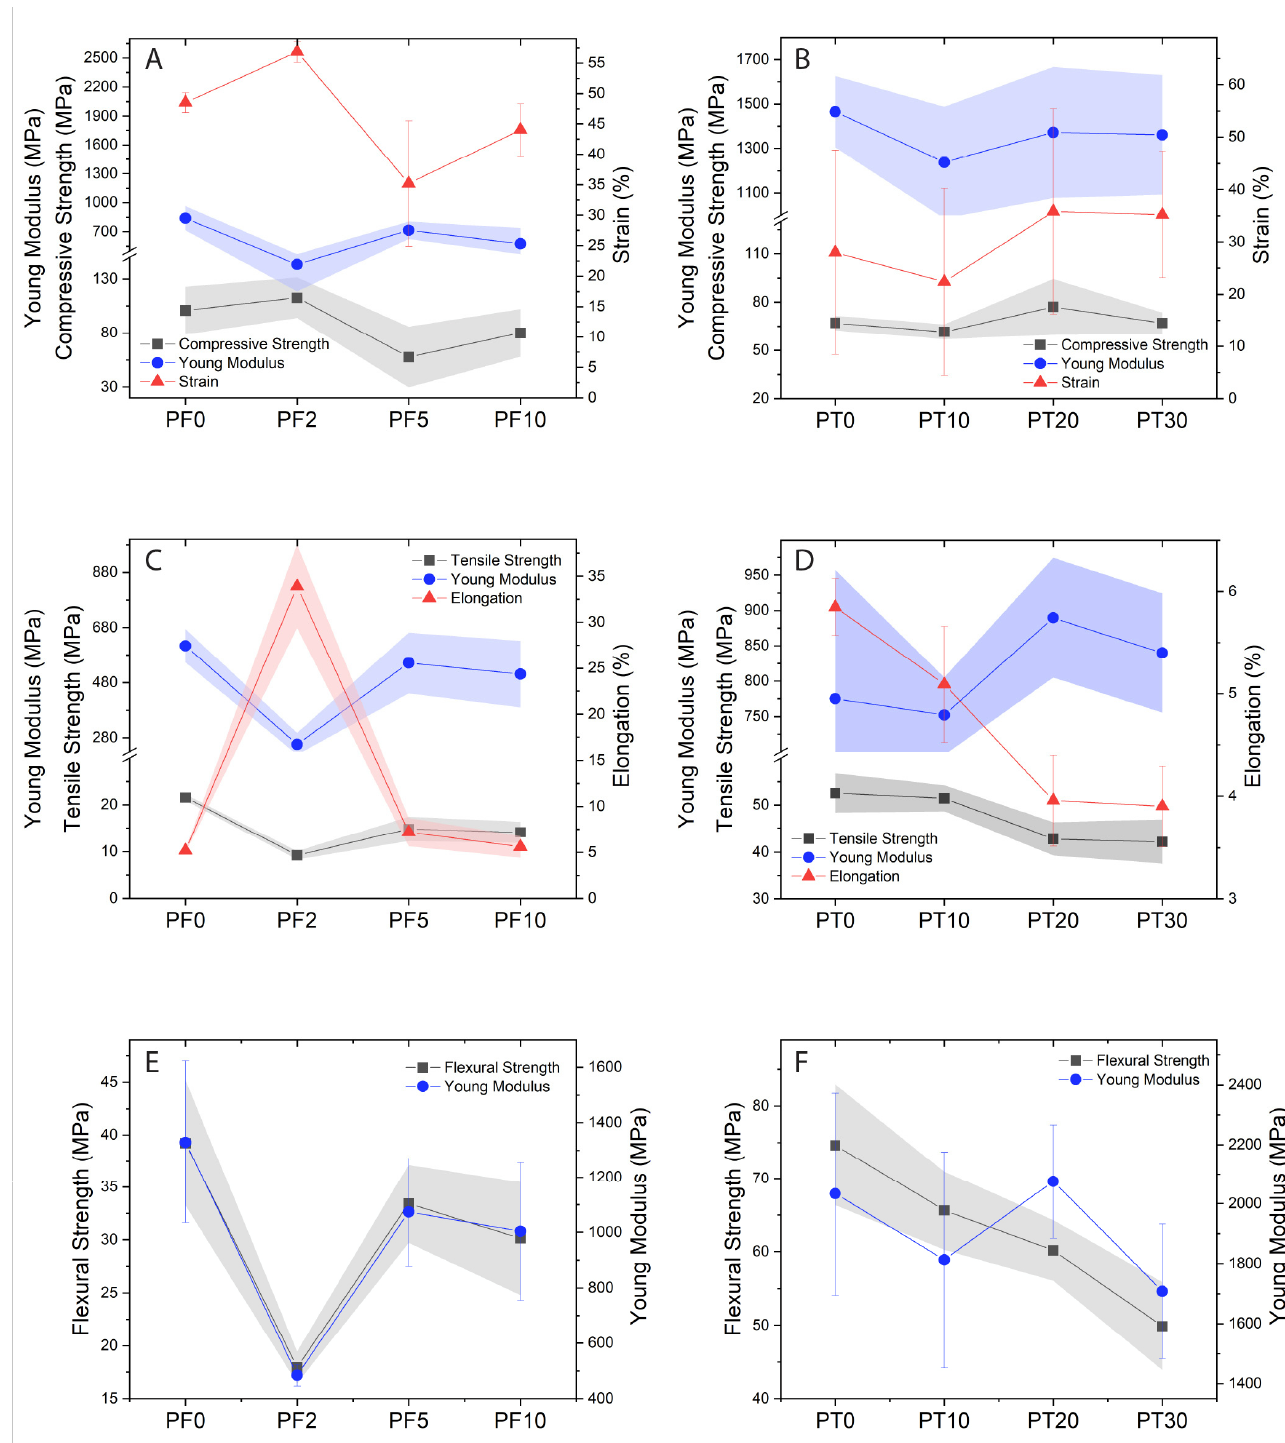
Figure 3. Variation of strength (compressive, tensile, and flexural), Young’s modulus, and deformation (strain and elongation) for the PF ( A , C , E ) and PT ( B , D , F ) composite samples. The DCAP-bearing PF samples show quite similar compressive stress–strain curves compared to the PF0, apart from sample PF2, which shows higher strain values under same stress conditions (Figures 2A and 3A), i.e., lower elasticity and higher plastic deformation. In fact, PF2 displays an increase in mean strain value (up to ~60%) compared to other samples (35–50%), followed by a decrease in Young modulus (~143 MPa vs. 574–840